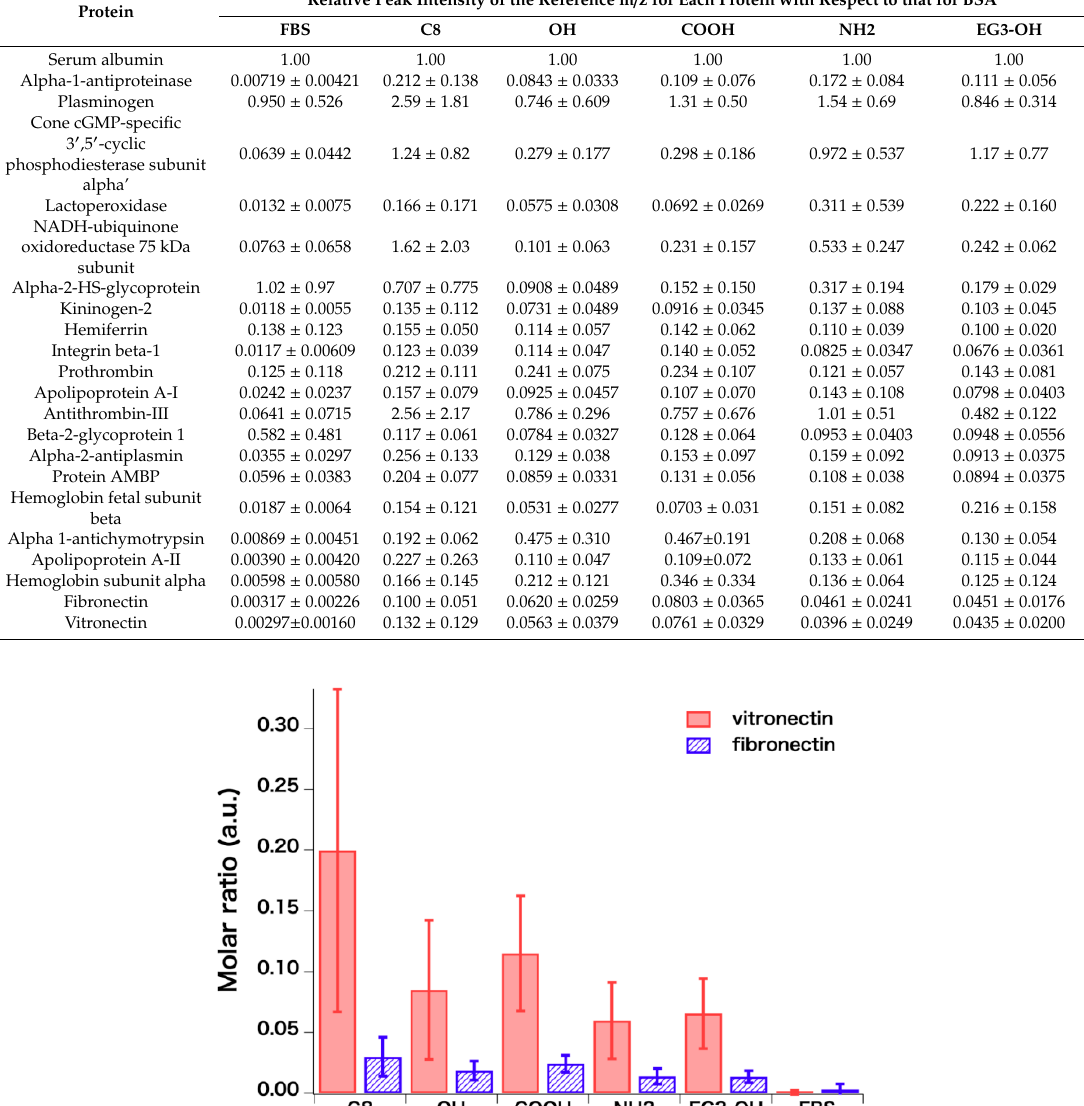
Table 3. Relative peak intensity of the reference m / z for each protein with respect to that of BSA in FBS and on the SAMs. Errors denote a standard deviation of 30 spectra (two substrates for each SAM with 15 spectra each at di ff erent positions).